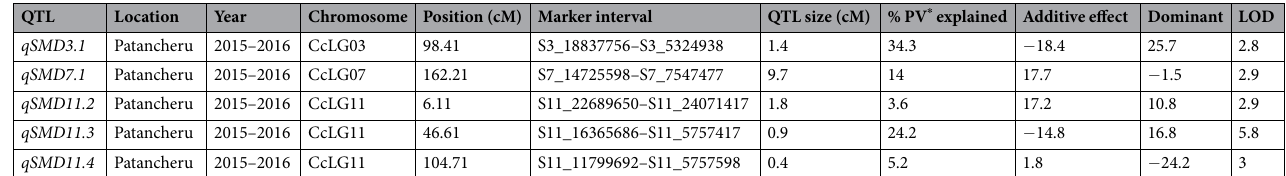
Table 4. Summary of QTLs for SMD resistance, position of the QTL on the map, percentage of phenotypic variance explained (% PV), additive and dominant effects, and LOD scores in ICP 8863 × ICPL 87119 (F2) population in pigeonpea. * % phenotypic